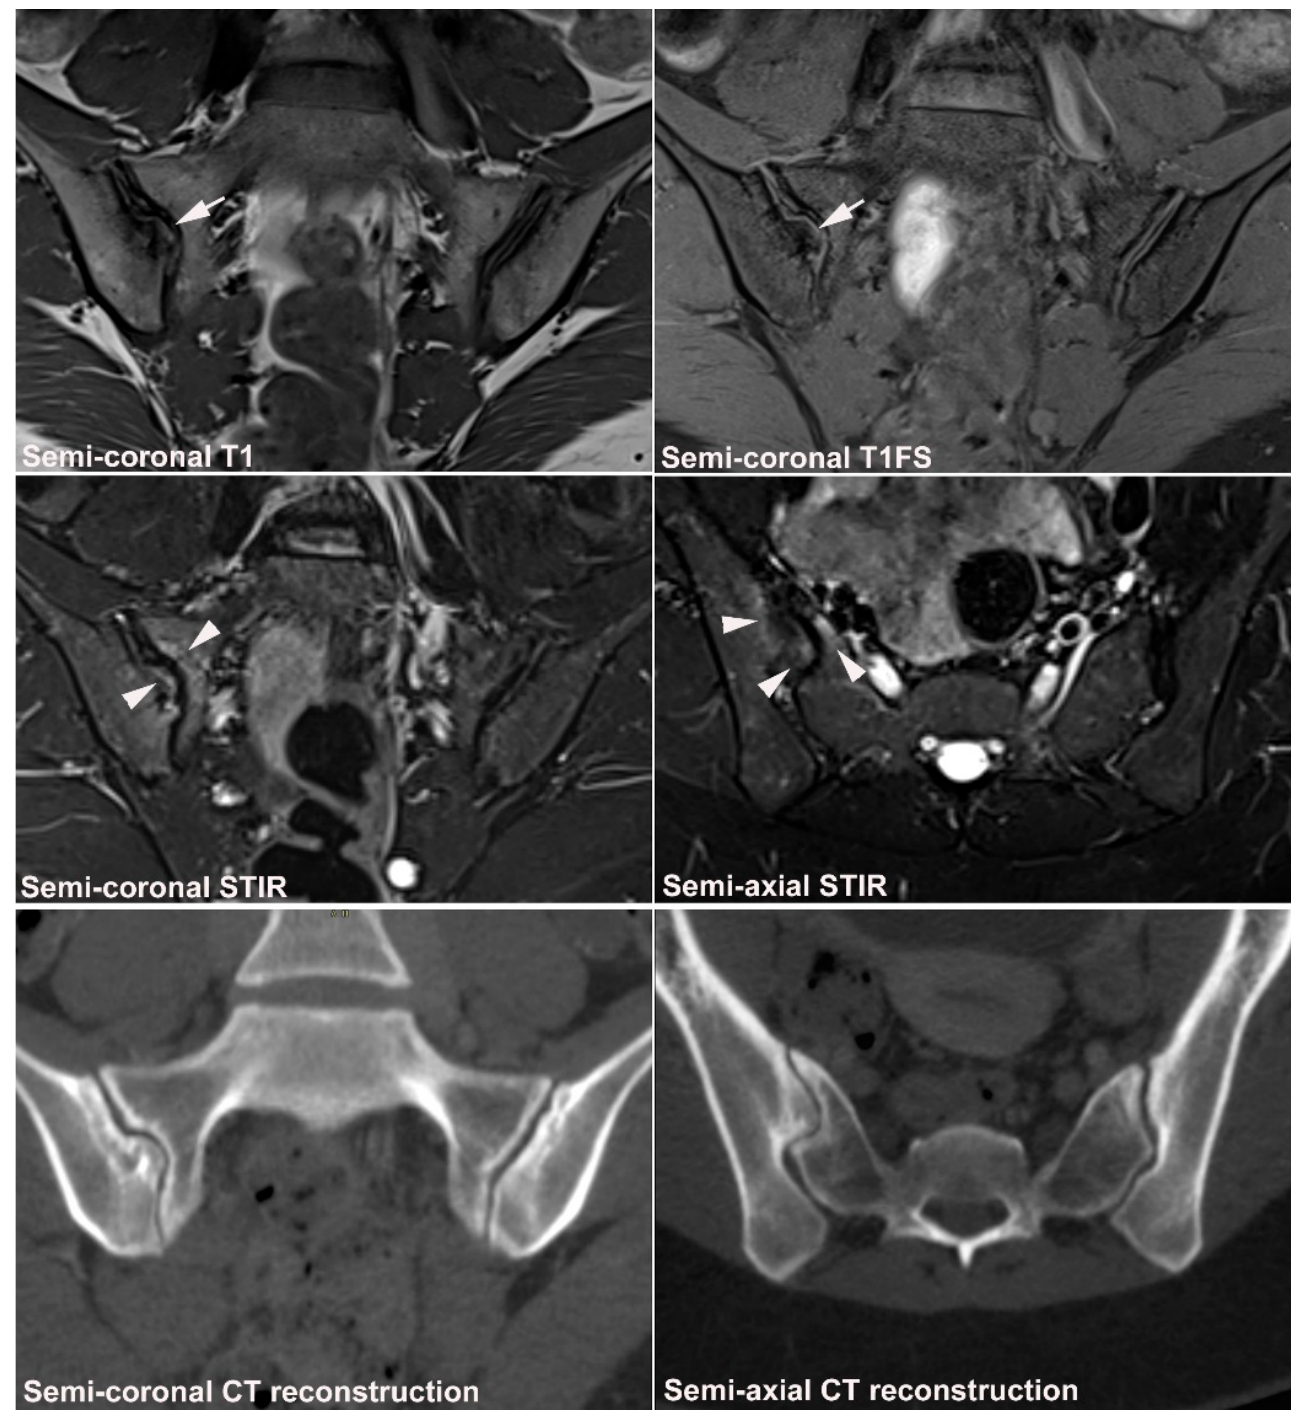
Figure 9. Dysmorphic SIJ in a 30-year-old woman with recurrent low back and right-sided buttock pain for three years. Semi-coronal T1, T1FS and STIR, and semi-axial STIR images with supplementary CT reconstructions in a semi-coronal and semi-axial orientation, respectively (lower row of images). There is manifest osseous protrusion of the right ileum into the sacrum with subchondral edema (arrowheads) and erosion-like irregularity at the iliac joint facet (arrows). The CT images clearly show the dysmorphic changes and absence of erosion.